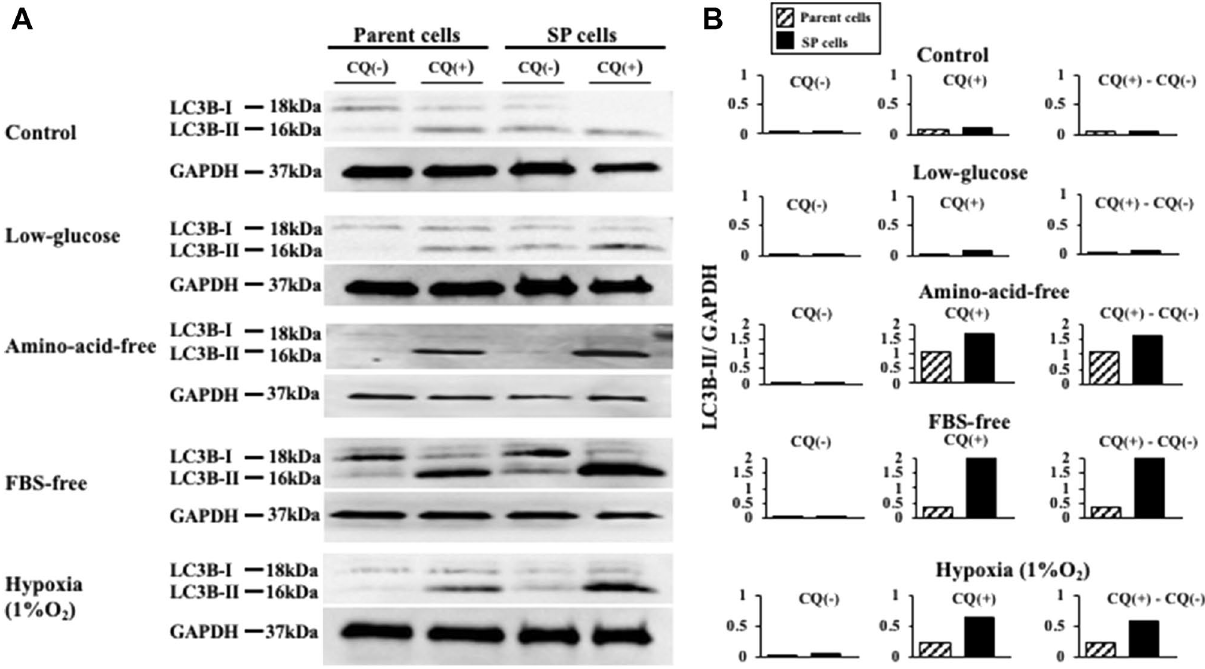
Figure 6. Autophagy flux of OCUM-12 cells. ( A ) Autophagy flux assay. ( B ) Autophagic flux was determined by subtracting the band intensity of the LC3B-II western blot in the presence of chloroquine (CQ +) and the corresponding treatment in the absence of chloroquine (CQ −). The expression of LC3B-II was higher in the OCUM-12/SP cells than in the parent OCUM-12 cells under amino-acid-free, FBS-free, and 1%O 2 conditions (LC3B/GAPDH ratio (CQ +)—LC3B/GAPDH ratio (CQ −); 1.61 and 1.07, 2.19 and 0.35, 0.58 and 0.22, respectively). The difference in LC3B-II expression was greatest under the FBS-free medium. The LC3B-II expressions under the control medium and low-glucose medium were slight (0.04 and 0.06, 0.07 and 0.02, respectively). The displayed membrane were cut prior to hybridization. The full-length original, un-processed blot performed with each antibody, LC3B and GAPDH, which confirms specific detection of the target antigen was presented in Supplement Figs. S1 and